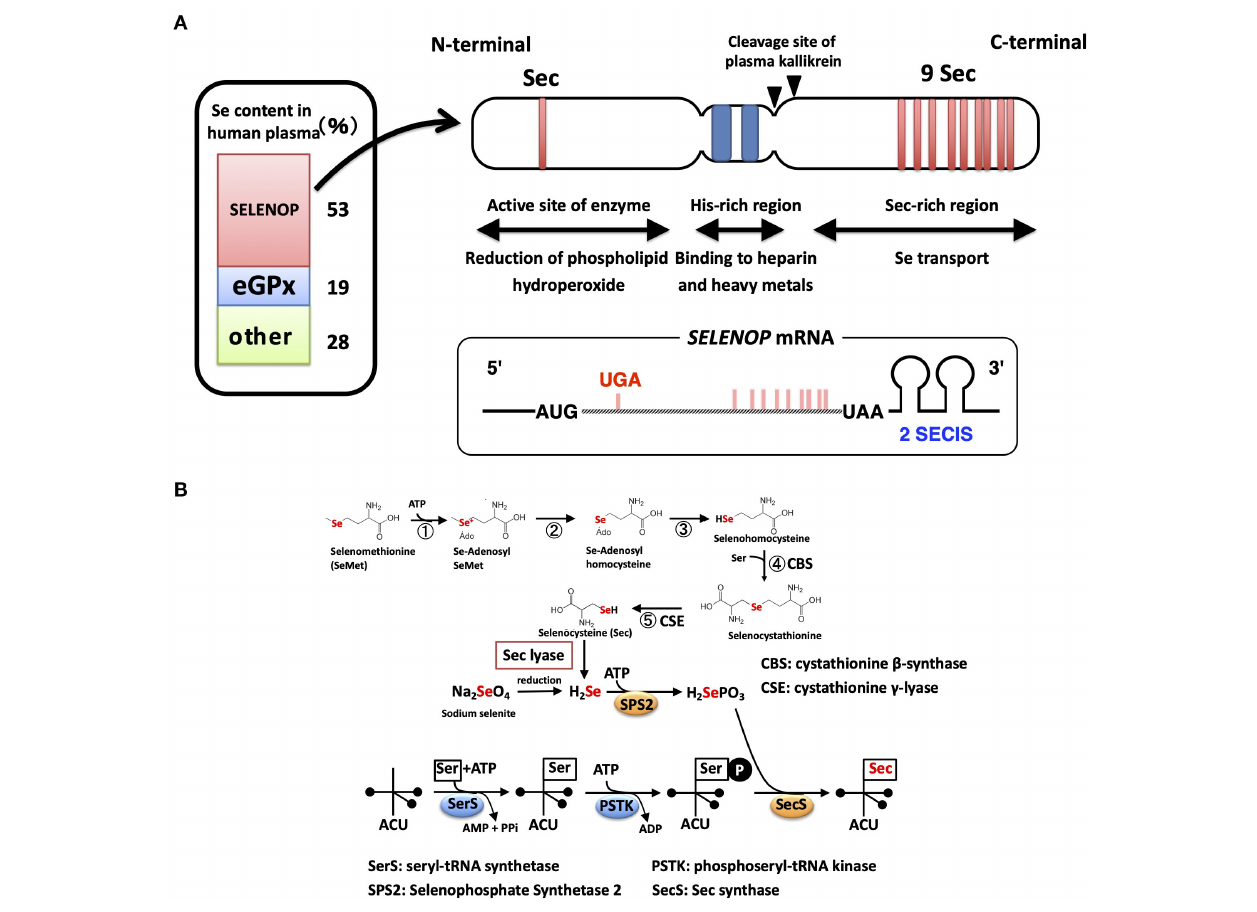
FIGURE 1 | Structure of the SELENOP and selenocysteine synthesis pathway. (A) Domain structure of human SELENOP. The Se content estimated from SELENOP- and eGPX-deficient human plasma is shown in the left panel. (B) Selenocysteine synthesis pathway. SeMet is converted to Sec with Met-metabolizing enzymes without discrimination with Met. Inorganic Se is produced with Sec lyase and used for the synthesis of